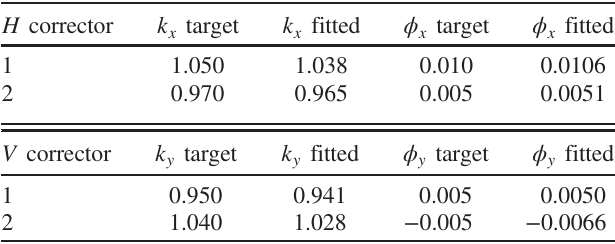
TABLE I. Corrector gains and rolls: Target vs fitted values.